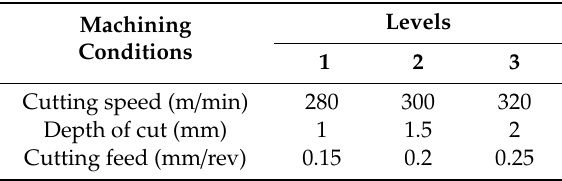
Figure 2. Four insert conditions. ( a ) Built-up edge; ( b ) Flank wear; ( c ) Normal; ( d ) Fracture. Table 1. Machining conditions and levels.